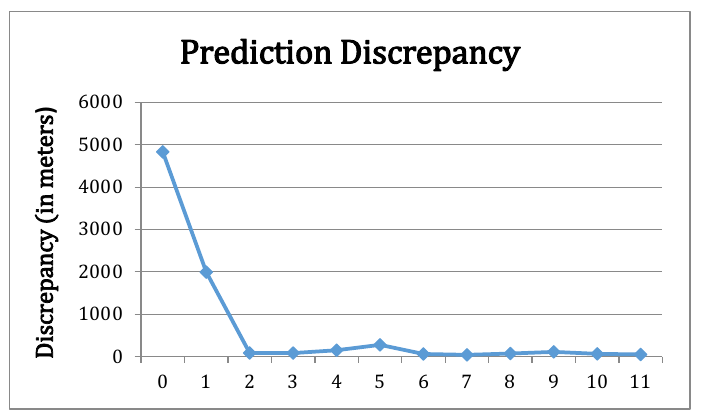
Figure 10. This shows the trend line of the prediction discrepancies. The discrepancies (Y-axis) are measured in meters.